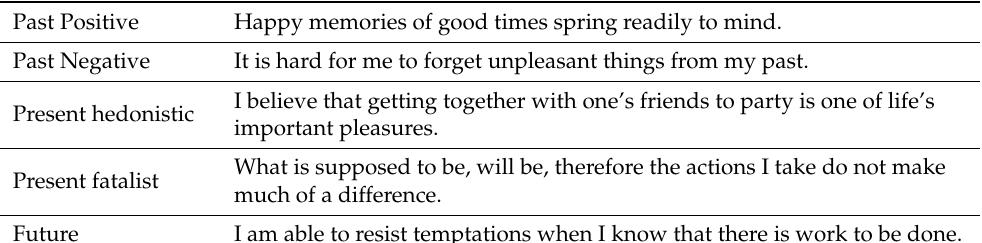
Table 1. Examples of questions from the ZTPI. Full questionnaire can be found in Supplement